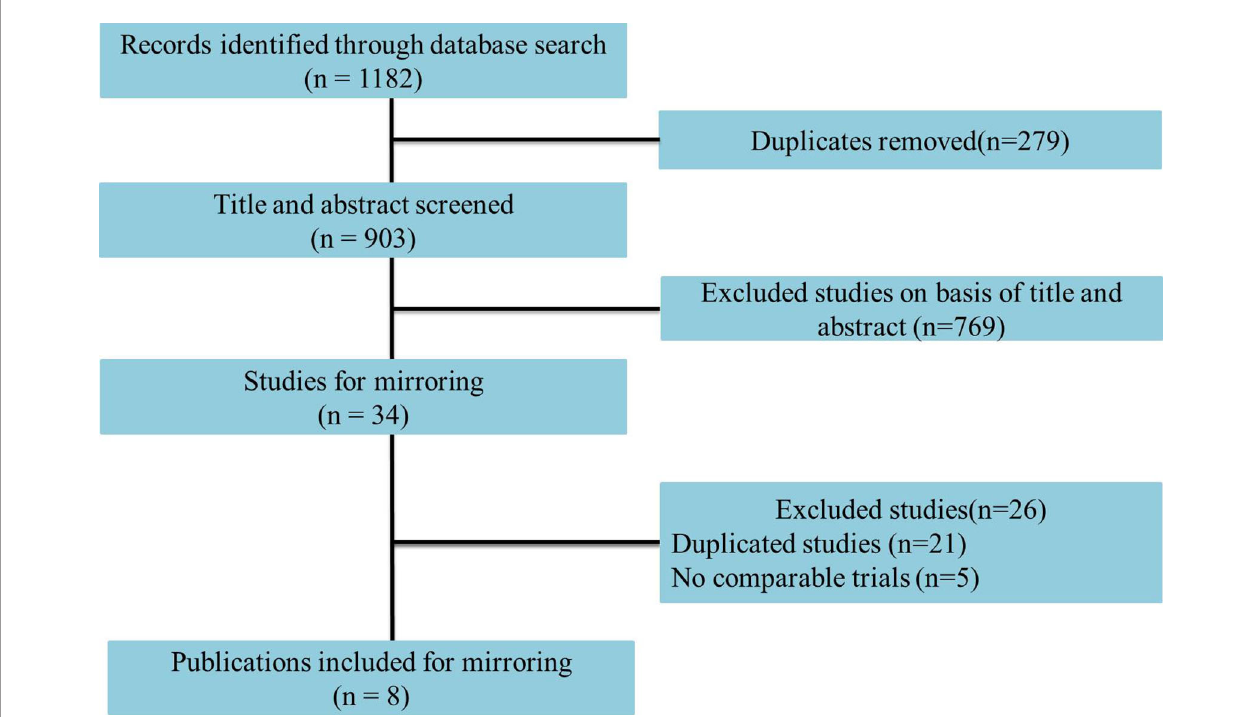
FIGURE 1 | Flowchart of study